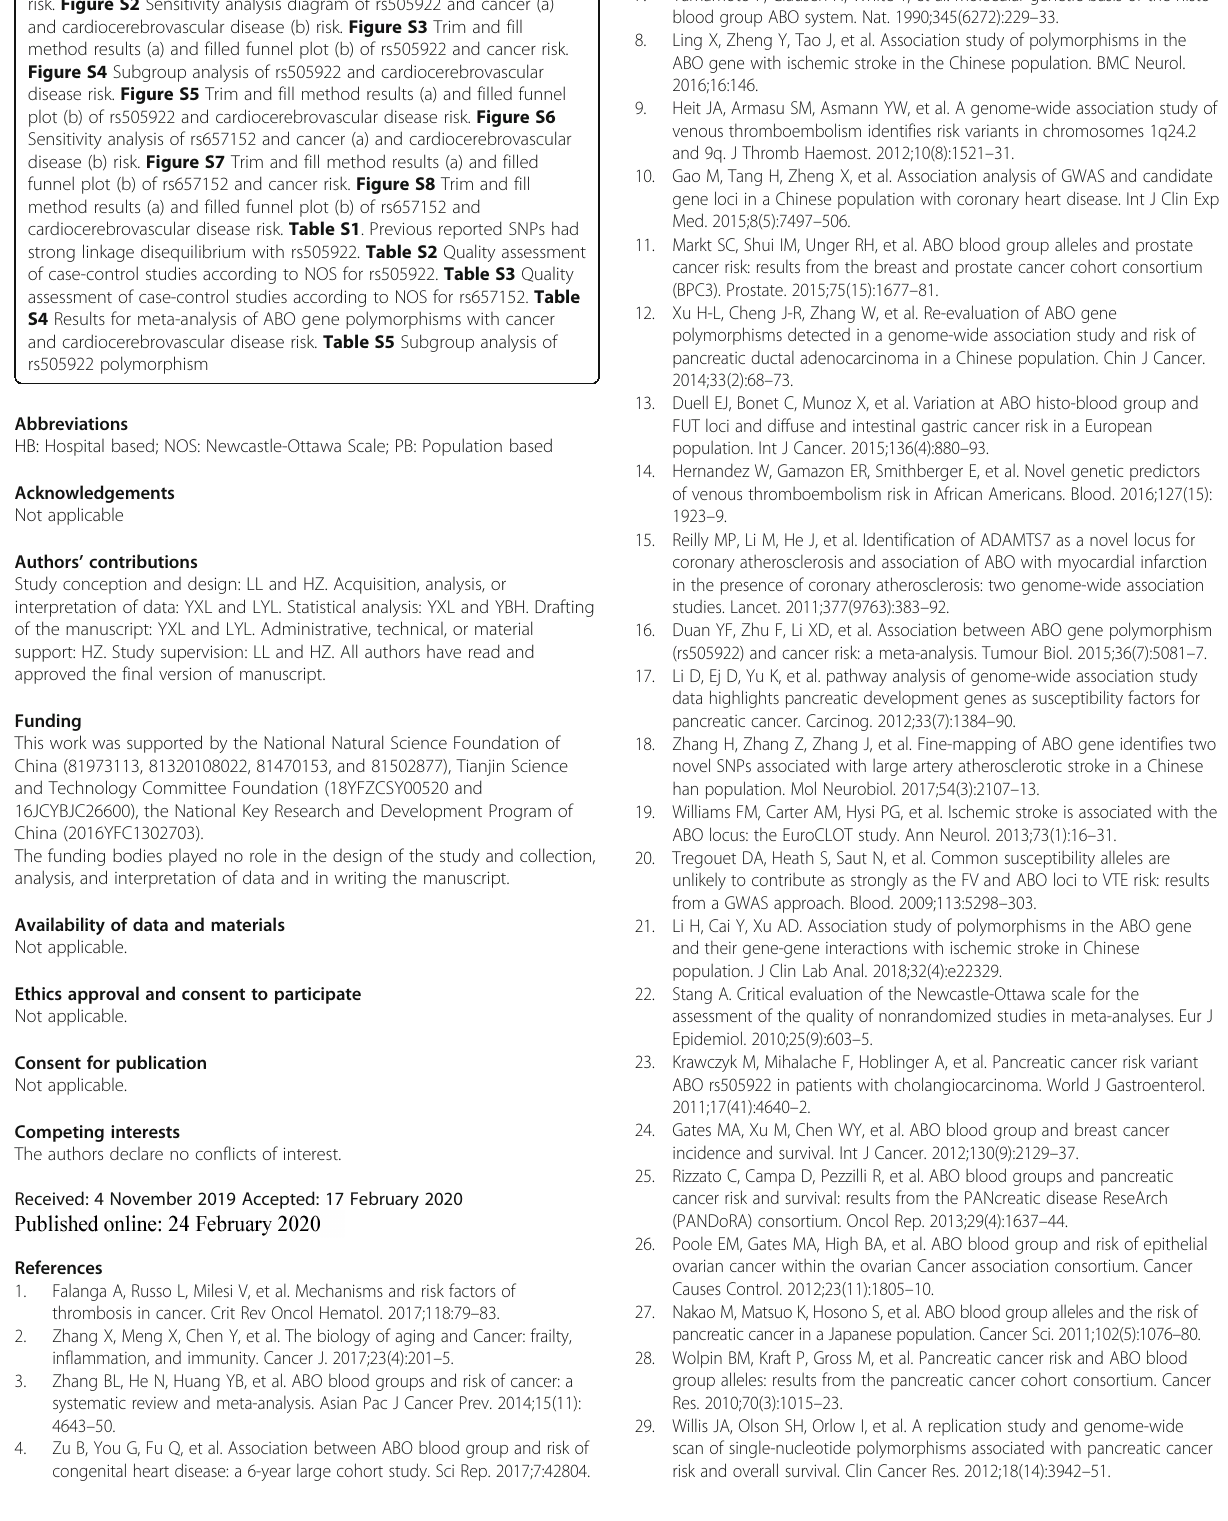
Additional file 1. Figure S1 Subgroup analysis of rs505922 and cancer risk. Figure S2 Sensitivity analysis diagram of rs505922 and cancer (a) and cardiocerebrovascular disease (b) risk. Figure S3 Trim and fill method results (a) and filled funnel plot (b) of rs505922 and cancer risk. Figure S4 Subgroup analysis of rs505922 and cardiocerebrovascular disease risk. Figure S5 Trim and fill method results (a) and filled funnel plot (b) of rs505922 and cardiocerebrovascular disease risk. Figure S6 Sensitivity analysis of rs657152 and cancer (a) and cardiocerebrovascular disease (b) risk. Figure S7 Trim and fill method results (a) and filled funnel plot (b) of rs657152 and cancer risk. Figure S8 Trim and